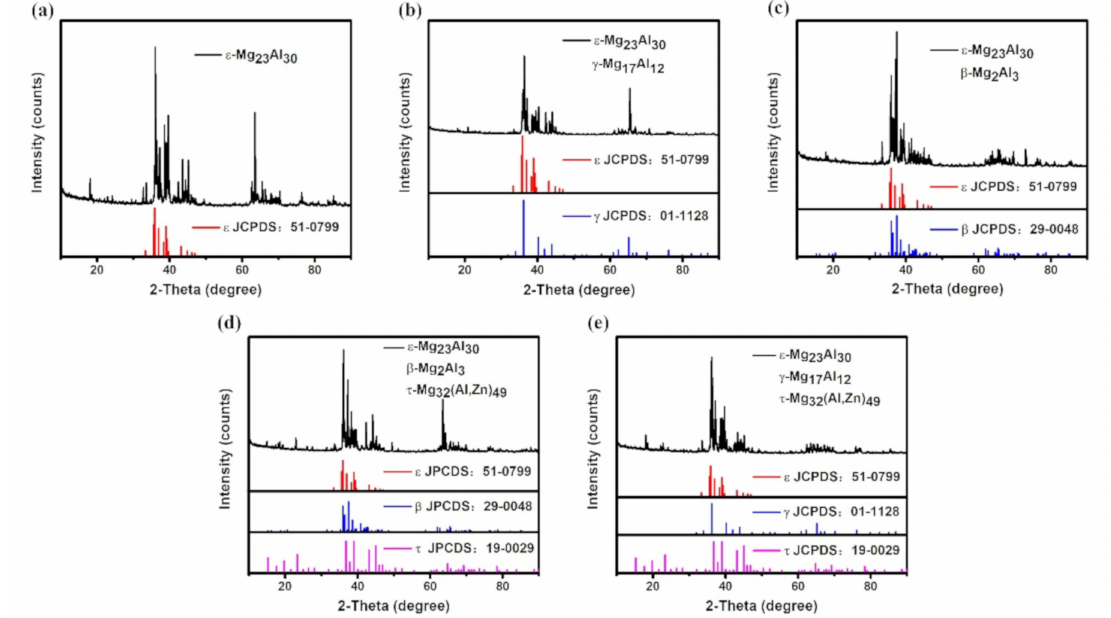
Figure 2. XRD patterns of samples annealed at 350 ◦ C for 305 h: ( a – e ) represent samples 1, 2, 3, 4, and 5, respectively. The experimental data points obtained by analyzing the XRD patterns and EPMA results are shown in Figure 3a, along with the isothermal section calculated at 350 ◦ C.